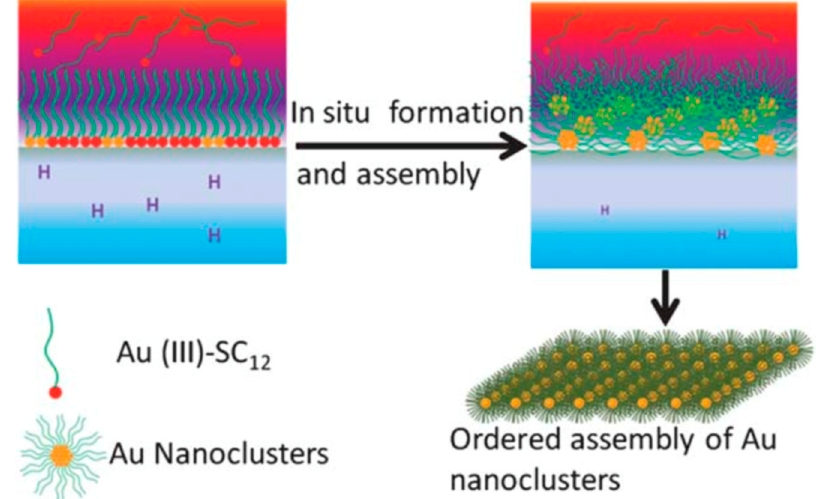
Figure 1. Schematic representation of the in situ formation and the assembly of Au nanoclusters (NCs) at an oil/water interface. Adapted with permission from Ref. [24]. Copyright (2011) Royal Society of Chemistry.